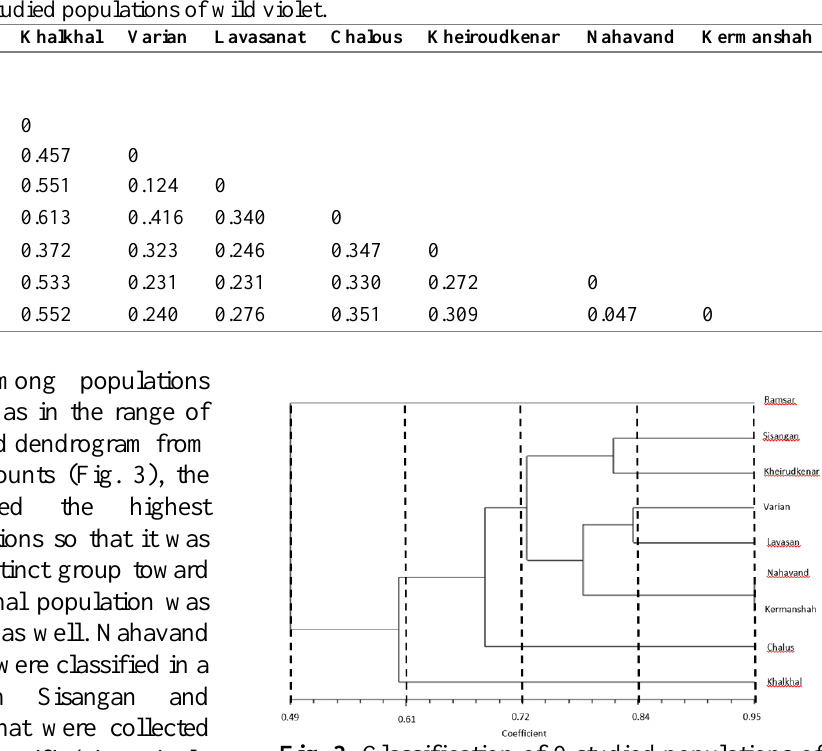
Fig. 3. Classification of 9 studied populations